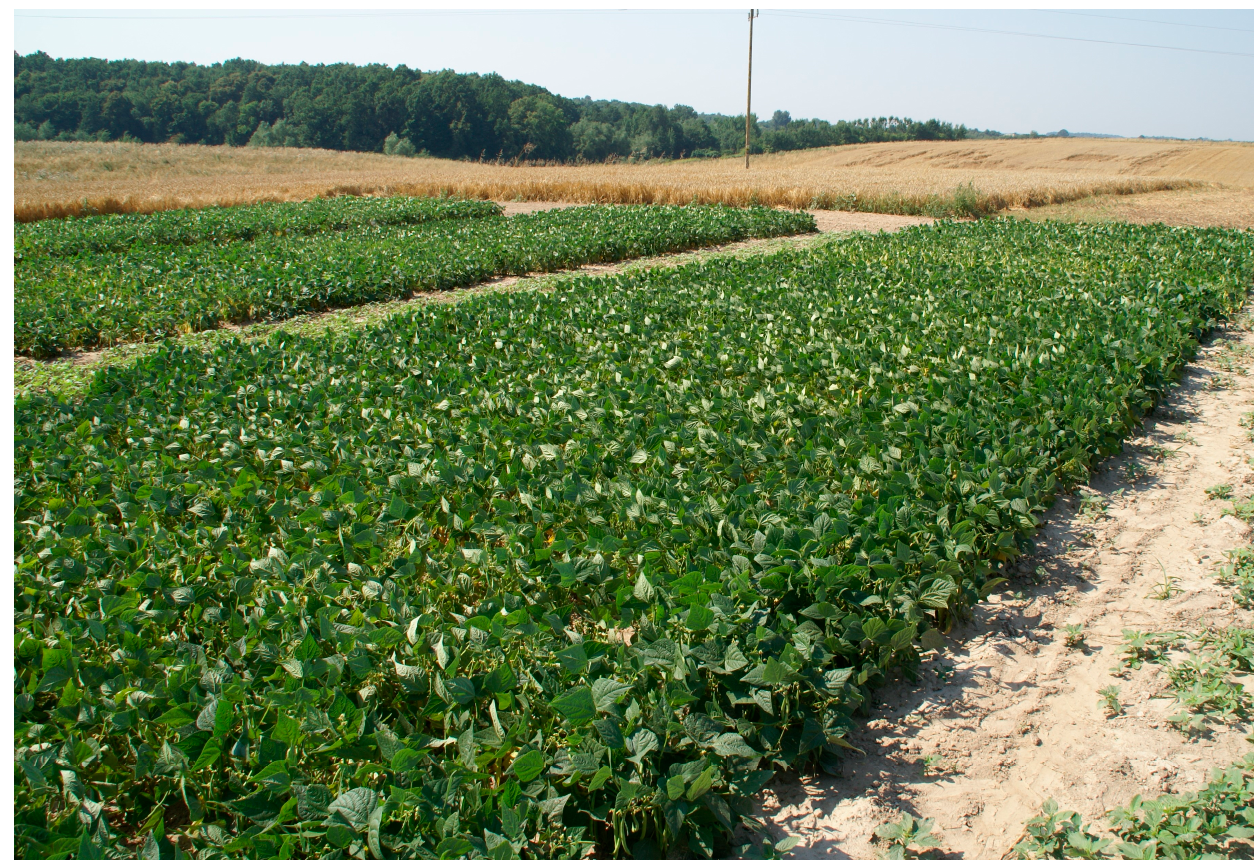
Figure 1. Experience with common beans in the green pod phase. Ż yznów 2019. Source: P. Pszczó ł kowski.